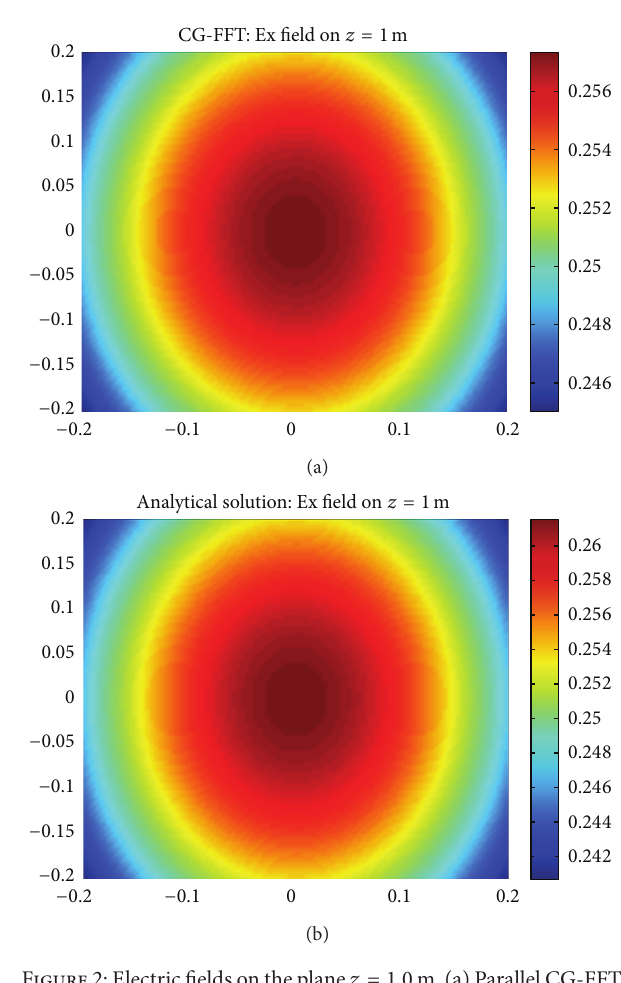
Figure 2: Electric fields on the plane 𝑧 = 1.0 m. (a) Parallel CG-FFT results. (b) Analytical results.